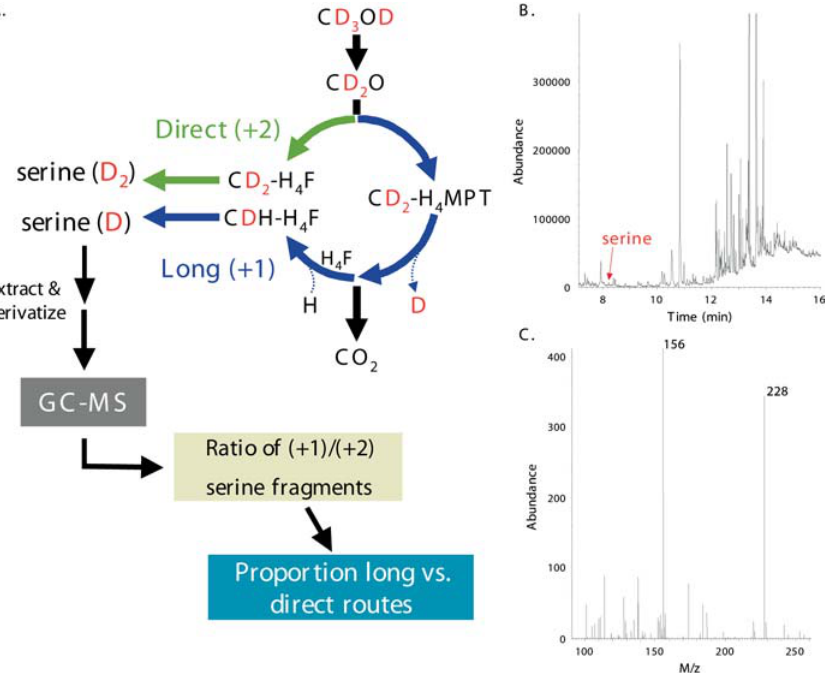
Figure 2. GC–MS Method to Assay Ratio of Long Versus Direct Routes (A) Simplified model of formaldehyde metabolism highlighting the deuterium (in red) label-tracing strategy. Oxidation of deuterated methanol (CD 3 OD) leads to the production of formaldehyde with two deuteriums (CD 2 O). Direct condensation with H 4 F (green arrows) and conversion to serine via the serine cycle (Figure 1) generates serine with two deuteriums. Alternatively, methylene-H 4 F may be produced through the long route (blue arrows; Figure 1), generating serine containing only one of the original deuteriums. Extraction and derivatizion of small molecules for analysis by GC–MS provides the ratio of ( þ 1)/( þ 2) serine isotopomers, thereby assaying the proportion of methylene-H 4 F generated via the long route through formate or from the direct route from formaldehyde. (B) Detection of serine by GC–MS. The small peak in total ion abundance detected by the MS denoted by the arrow represents serine. (C) Analysis of the mass fragments present in this peak revealed the presence of ions with M/z values of 156 and 228, which are diagnostic for ECF–TFAA derivatized serine. DOI: